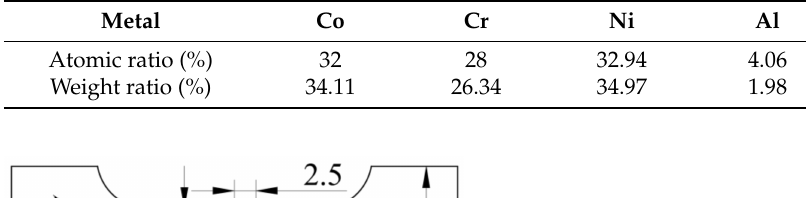
Table 1. Atomic and weight ratios of the principal elements of Co 32 Cr 28 Ni 32 . 94 Al 4 . 06 Ti 3 .